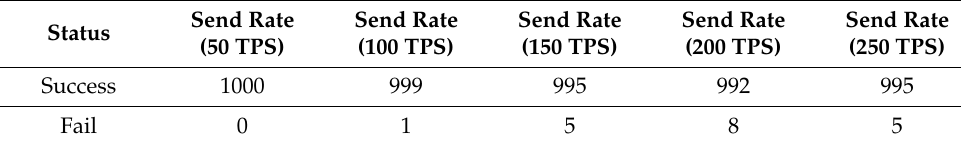
Table 7. Transaction status of 1000 reading in the private